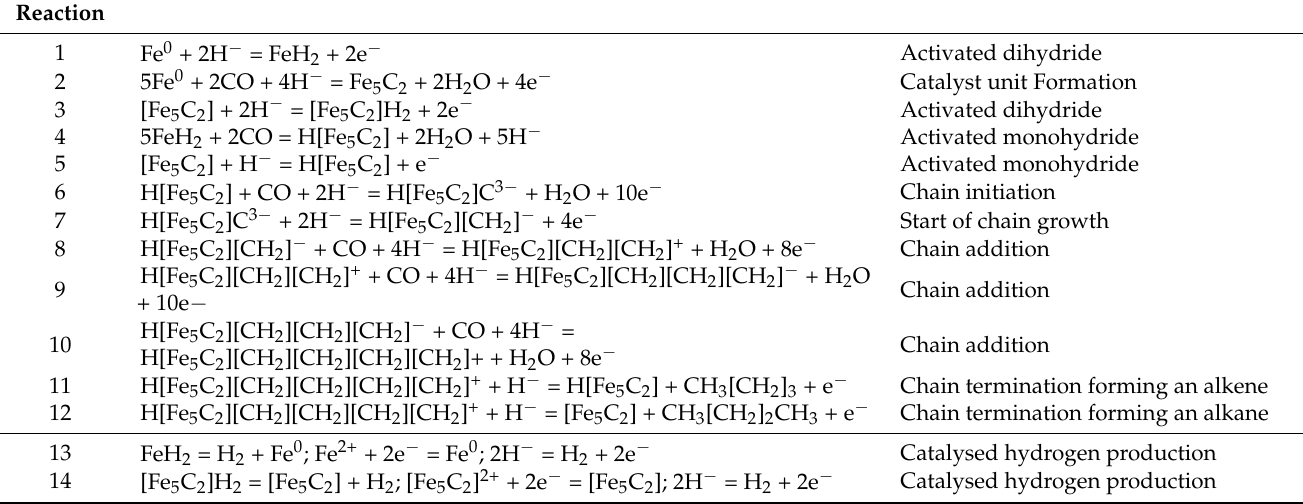
Table 15. Alkane formation reactions in Stability Field 2 : alkyl chain growth mechanism.